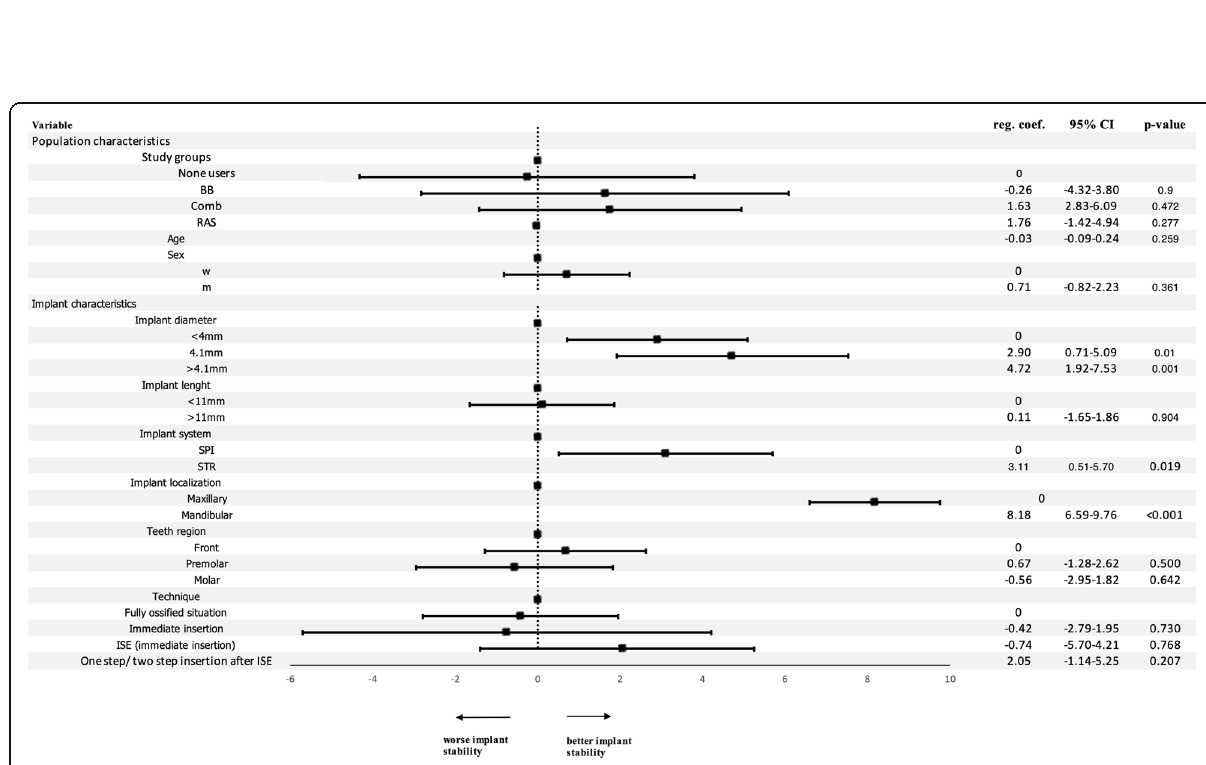
Fig. 3 Regression model of the implant stability quotient (ISQ) at implant insertion. BB, beta-blocker group; Comb, combined beta-blocker and RAS-inhibitor group; RAS, RAS inhibitor group; m, male; f, female; ISE, internal sinus elevation; STR, Straumann implants; SPI, Thommen implants; reg. coeff., regression coefficient; 95% CI 95% confidence